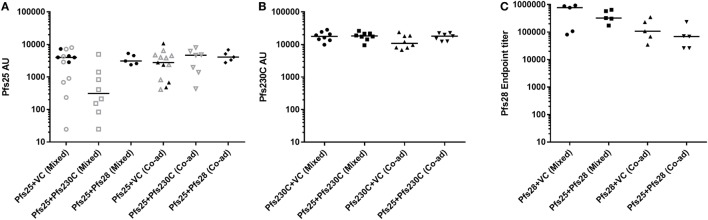
Immunogenicity of chimpanzee adenovirus 63 (ChAd63)–modified Vaccinia Ankara (MVA) vaccination with mixed or co-administered antigens in mice. Day 70 antigen-specific IgG responses in mice after immunization with ChAd63-MVA expressing Pfs25, Pfs230, Pfs28, and GFP [vector control (VC)] antigens. Constructs were administered by premixing antigens prior to vaccination (mixed) or co-administering (Co-ad) by vaccinating each antigen separately. The figure shows the total IgG response against Pfs25 [(A) two independent immunization experiments were conducted of experiment 1: n = 8/group (open symbols) and experiment 2: n = 5/group (closed symbols)], Pfs230C (B), and Pfs28 (C). Response was measured by standardized ELISA (A,B) and expressed in antibody units. Anti-Pfs28 antibody levels were measured by endpoint ELISA (C) and expressed as Pfs28 endpoint titer. Median and individual data points are shown. Kruskal–Wallis tests showed p = 0.0682 (A), p = 0.2445 (B), and p = 0.0304 (C), respectively. Dunn’s multiple comparison posttests showed no significant difference.